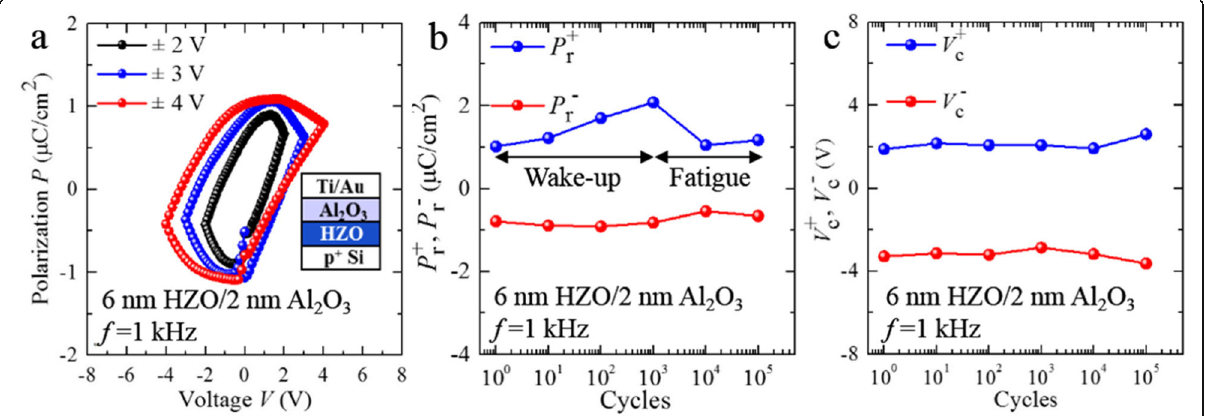
Fig. 2 a P-V hysteresis loops for the HZO (6 nm)/Al 2 O 3 (2 nm) capacitor with different voltage sweeping ranges. Dependence of ( b ) P r and c V c on cycling for the HZO (6 nm)/Al